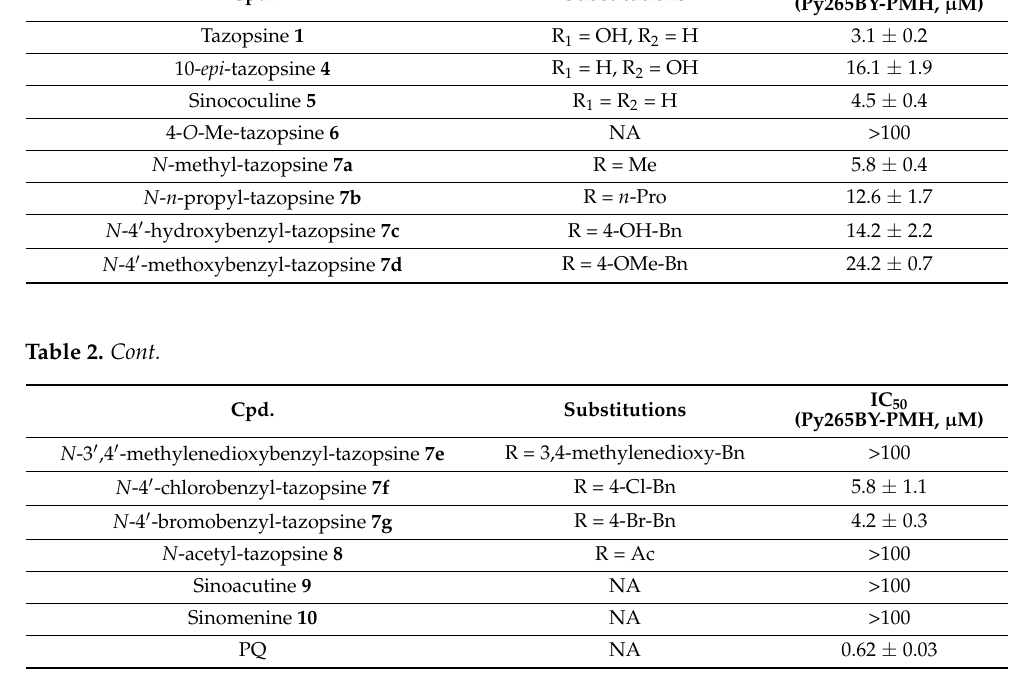
Table 2. In vitro IC 50 values of tazopsine 1 , derivatives 6 – 8 and natural ent -morphinan alkaloids in P. yoelii liver stages. IC 50 values are the mean of four technical replicates. PMH: primary mouse hepatocytes; NA: not applicable; PQ: primaquine. Cpd.